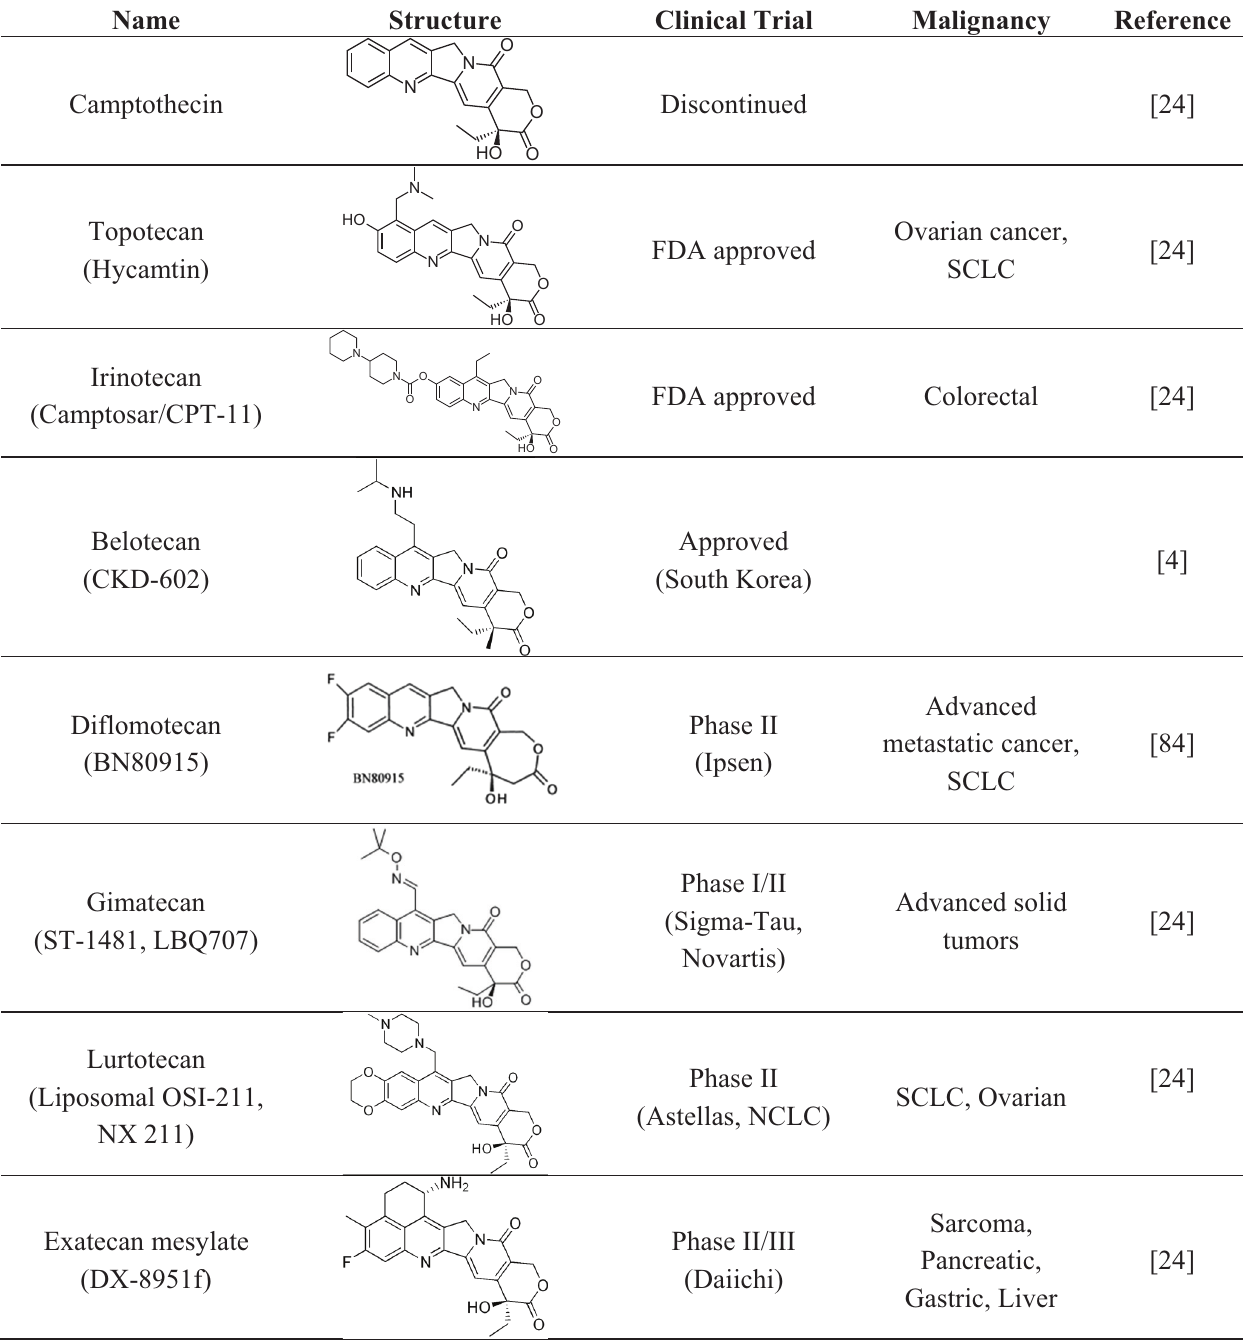
Table 1. CPT derivatives in clinical trials